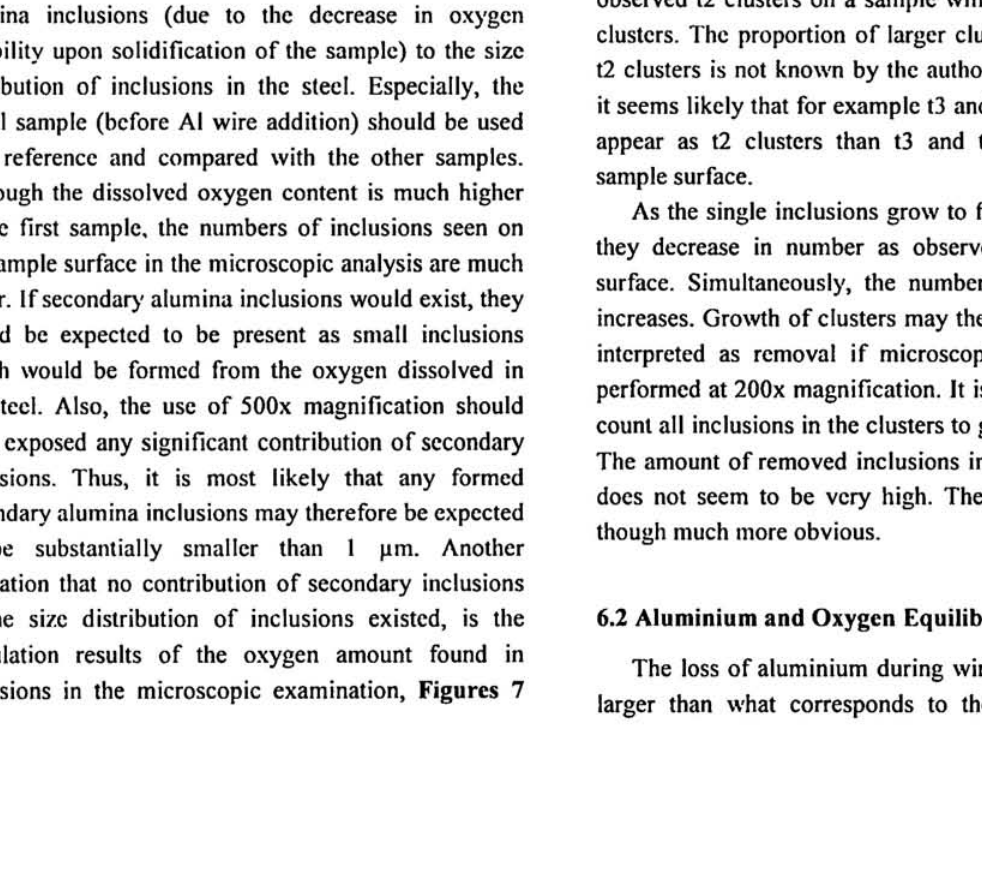
Fig. 17: Results of model calculation case 4 with no. of inclusions per unit